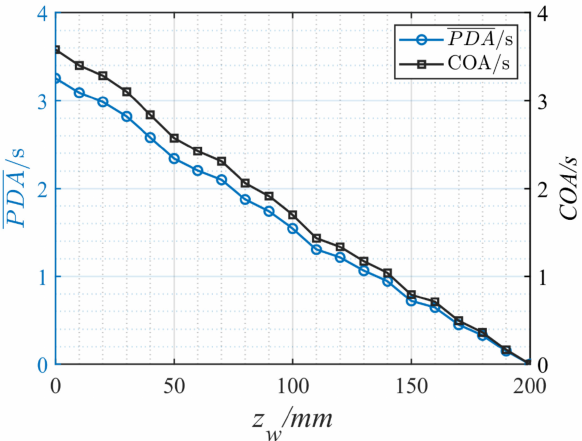
Figure 16. Comparison of two methods for calculating the final offset